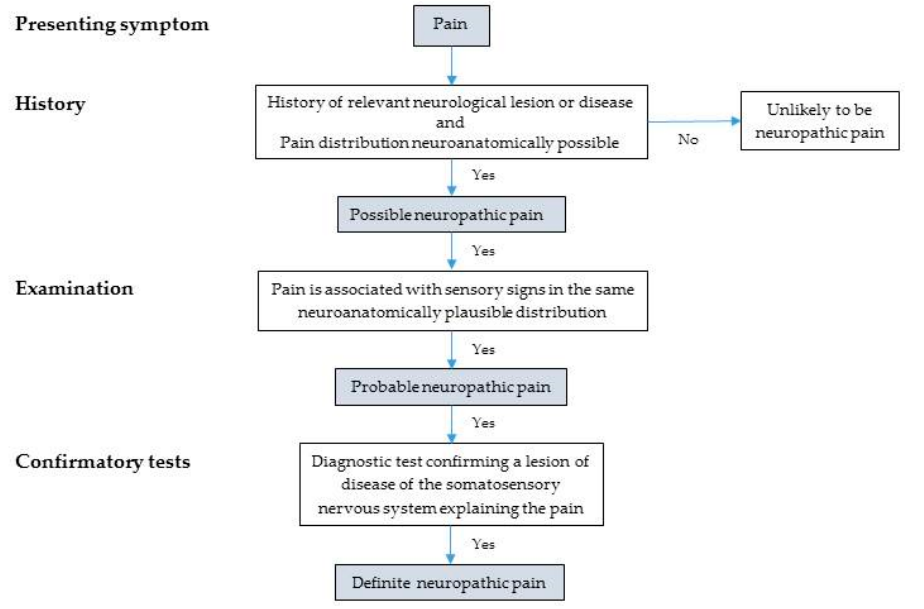
Figure 1. NeuPSIG upgraded system for neuropathic pain. Adapted from Finnerup et al. [22].